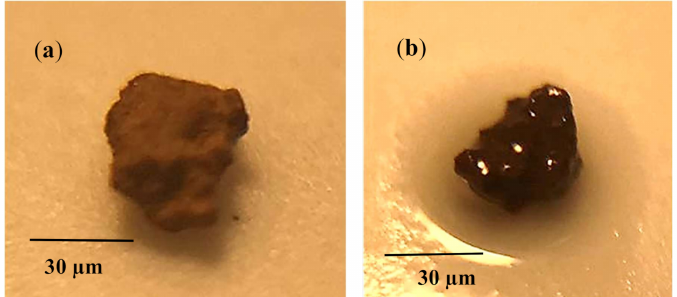
Figure 5. Optical image of dust particle: ( a ) before oil infusion, and ( b ) after oil infusion. Infused oil covers the dust particle surface, which indicates the positive spreading coefficient of oil over the particle